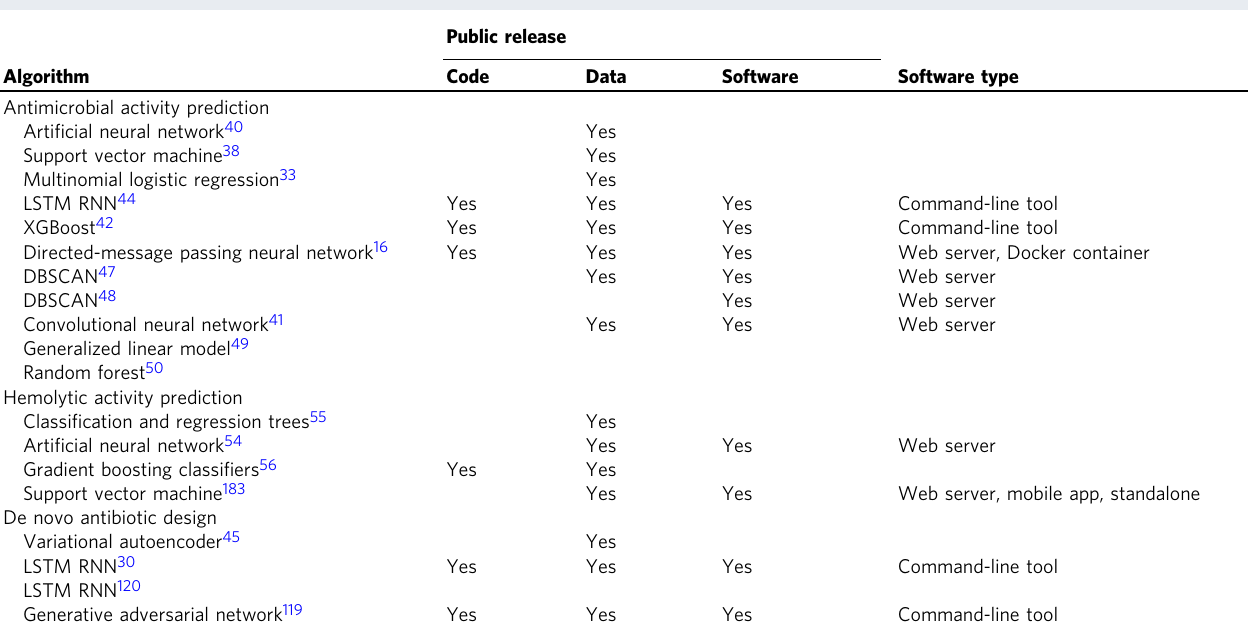
Table 2 Machine learning models for antibiotic